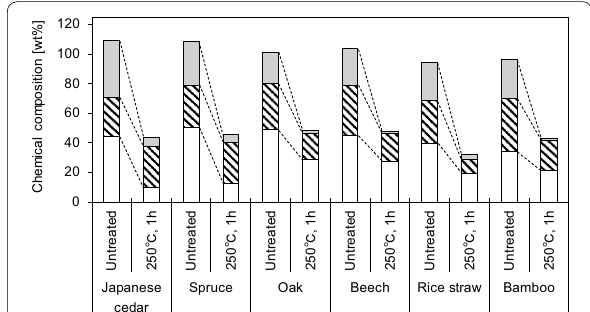
Fig. 4 Changes in chemical composition of different biomasses treated with 20% sodium oleate in glycerol at 250 °C for 1 h. White area, ɑ -cellulose; hatched area, hemicellulose and alkali-soluble cellulose; gray areas, Klason